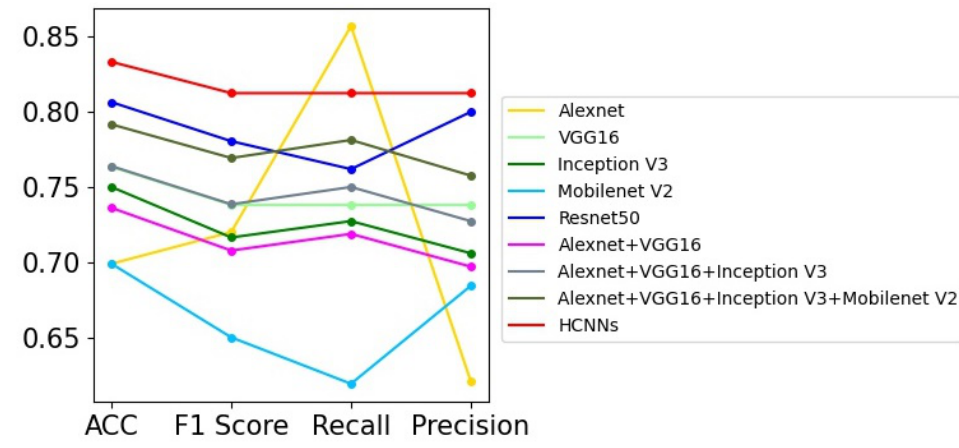
Figure 4. The curve graph of Table 2.